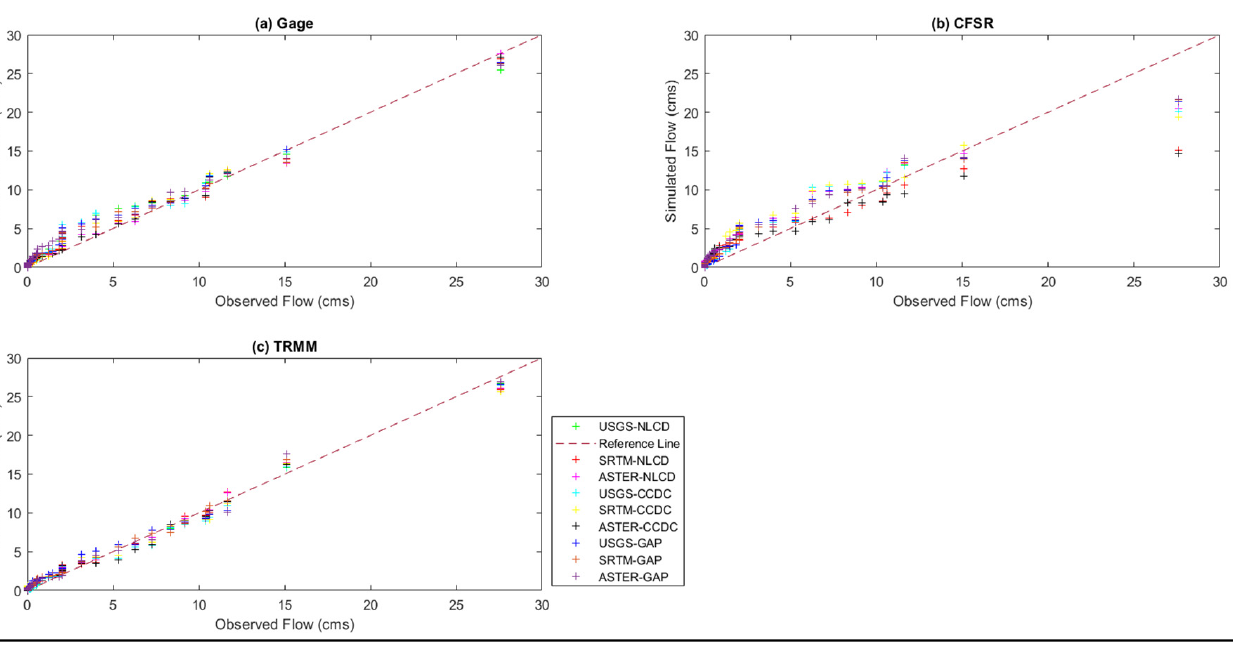
Figure 14. Variation of simulated flows with observed flows was obtained for the three precipitation datasets as ( a ) Gage, ( b ) CFSR, and ( c ) TRMM with nine different combinations for the Little River watershed.